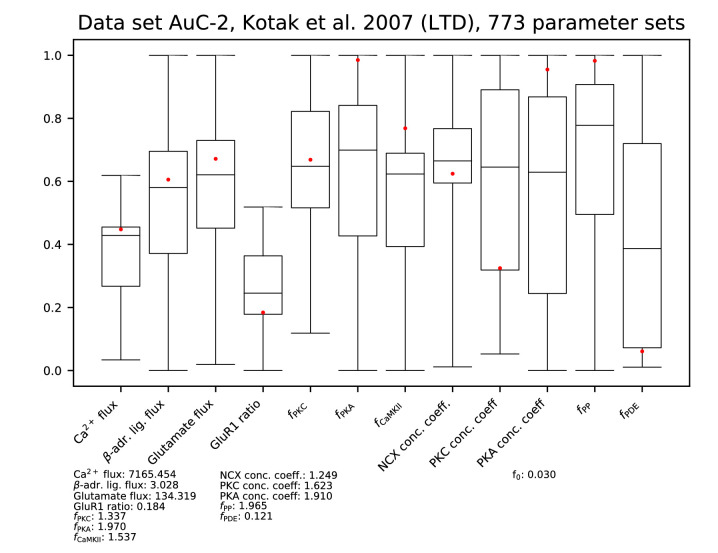
Parameters for data set AC-2.See Figure 9—figure supplement 1 for details.